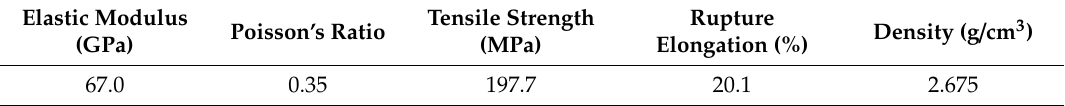
Figure 4. Tensile test of Japanese Industrial Standards No. 5 specimen. Table 1. Material properties of the aluminum alloy used in this research.